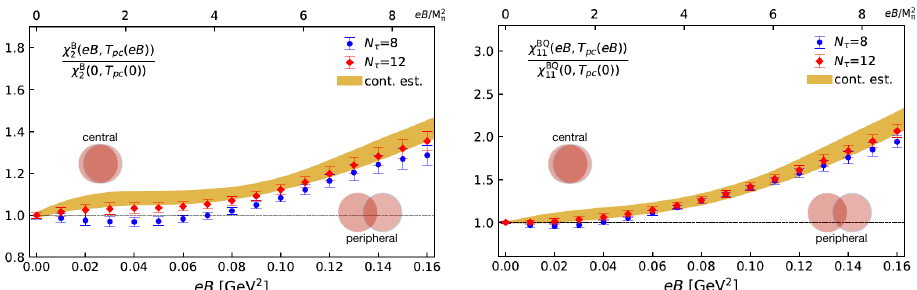
Figure 3. Left panel: normalised second order fluctuations of baryon number along the transition line as a function of the magnetic field strength. Right panel: similar to the left panel for the normalized second order correlations between baryon number and electric Figure 2. Left panel: scaled second order cumulants of net-proton distributions as a function of the acceptance coverage around mid-rapidity, measured by the ALICE experiment (black symbols) [32, 33]. The colored lines correspond to calculations accounting for baryon number conservation for di ff erent values of the correlation coe ffi cient in the rapidity space [18, 34]. The solid black line represents the results from the HIJING event generator. Right panel: a schematic illustration of baryon production mechanisms via the Lund string model.